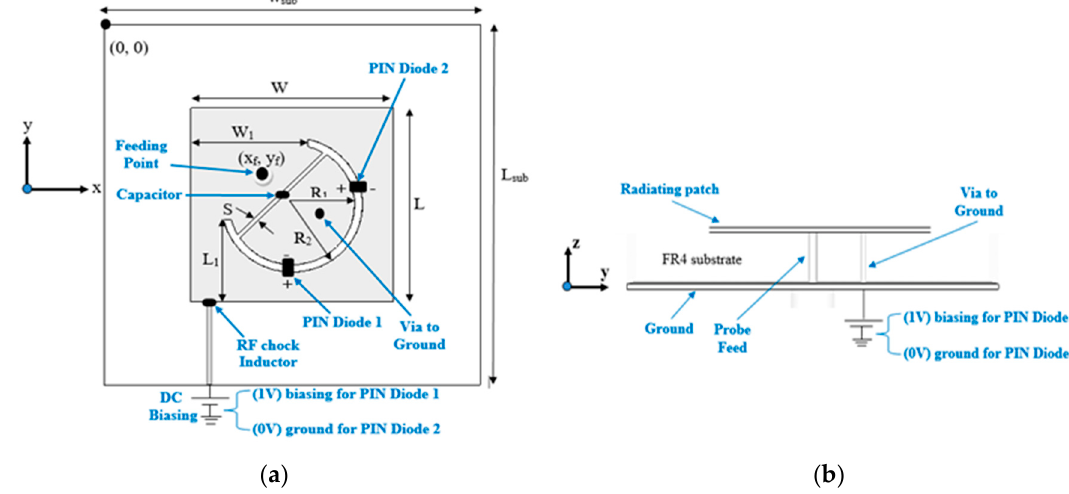
Figure 1. Proposed polarization-reconfigurable patch antenna: ( a ) Top view; ( b ) Side